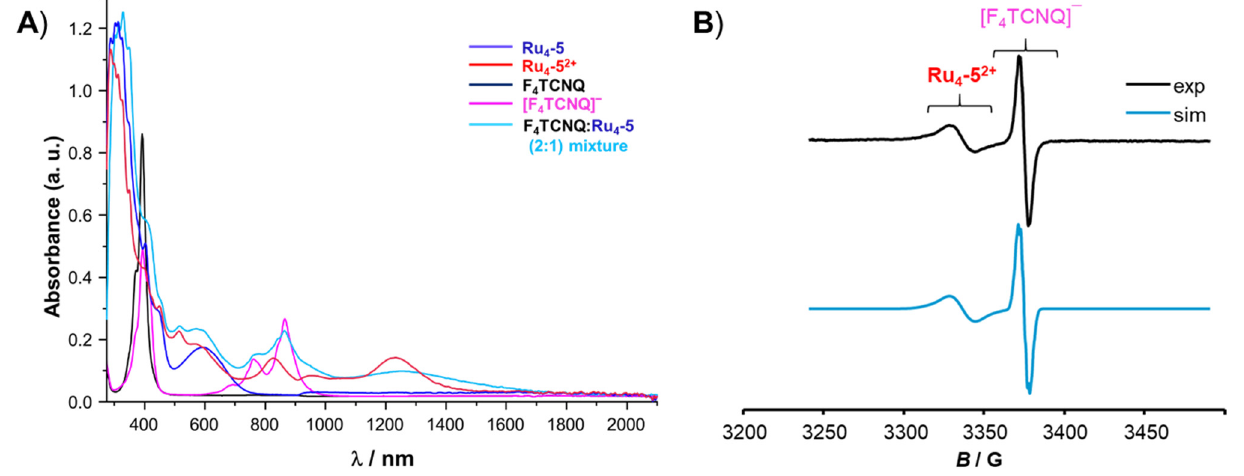
Figure 9. ( A ) UV–vis–NIR and ( B ) EPR spectra of salt CT-1 synthesized by the reaction of 2 equivalents of F 4 TCNQ with Ru 4 -5 in CH 2 Cl 2 at 298K. The experimental spectrum is shown at the top and the simulated one at the bottom.